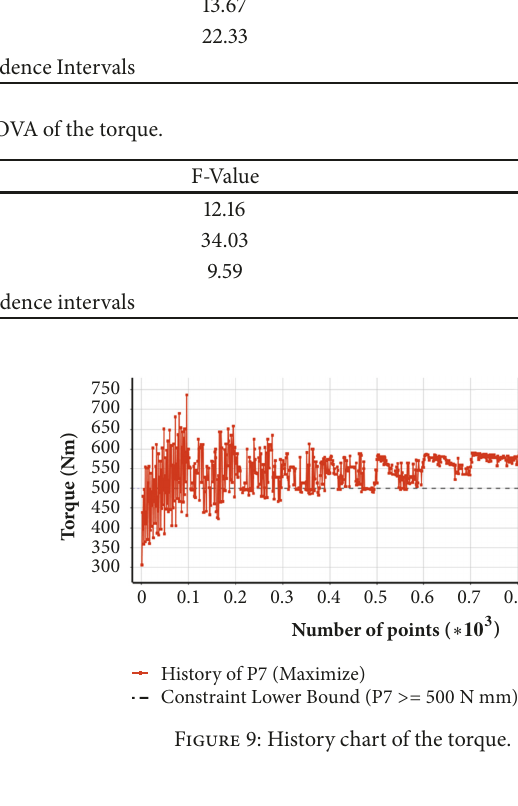
Figure 8: History chart of the strain energy.